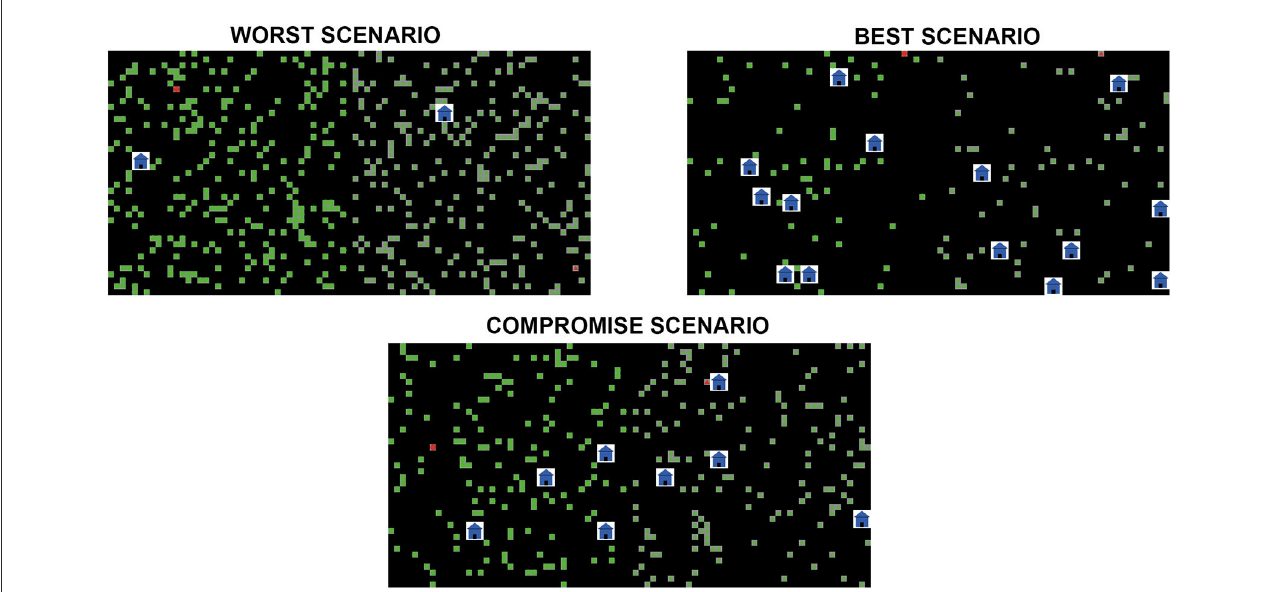
FIGURE3 Sample initialization ( t = 0) of the three scenarios: top-left is the worst scenario, bottom-center is the compromise scenario, and top-right is the best scenario. Generally, all scenarios have the same barangays: barangay A and barangay B. The gray square grid is a household and the white larger grid with an image of a house at its center is a marketplace . The green shapes are the susceptible residents, while the red ones are the initially infected residents . Each scenario only differs in the number of households and marketplaces counts where the values set can be seen in Table 6. Sample simulation videos for each scenario are provided as Supplementary material. The Netlogo file used in this simulation can be accessed through this GitHub link: https://